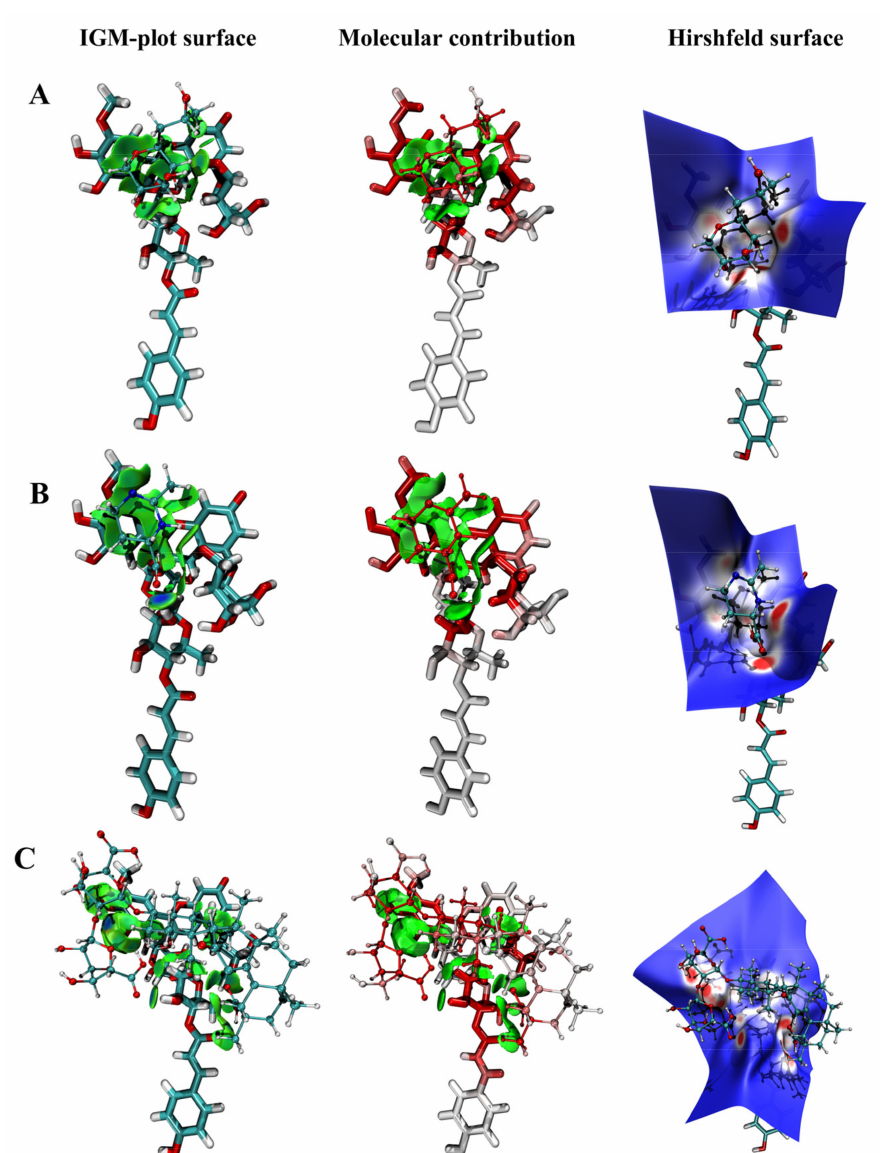
Figure A8. Non − covalent interaction for the anthocyanin (A7 species) compound − binary complex